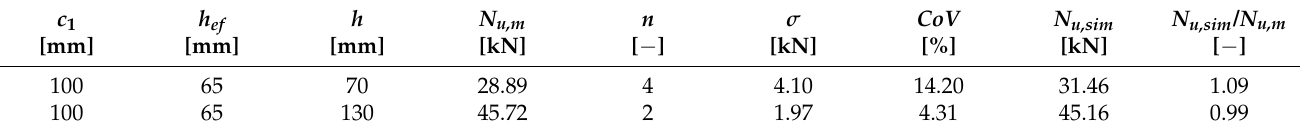
Table 4. Comparison between experimental and numerical results—plain concrete